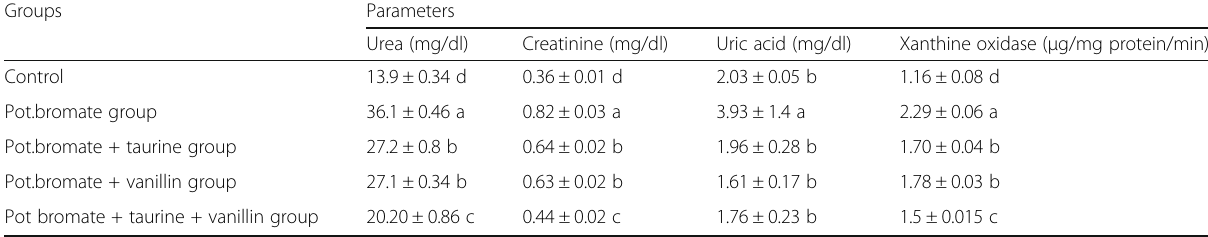
Table 3 Effect of taurine and/or vanillin on serum urea, creatinine, uric acid, and renal-homocysteine of the potassium bromate- treated rats Groups